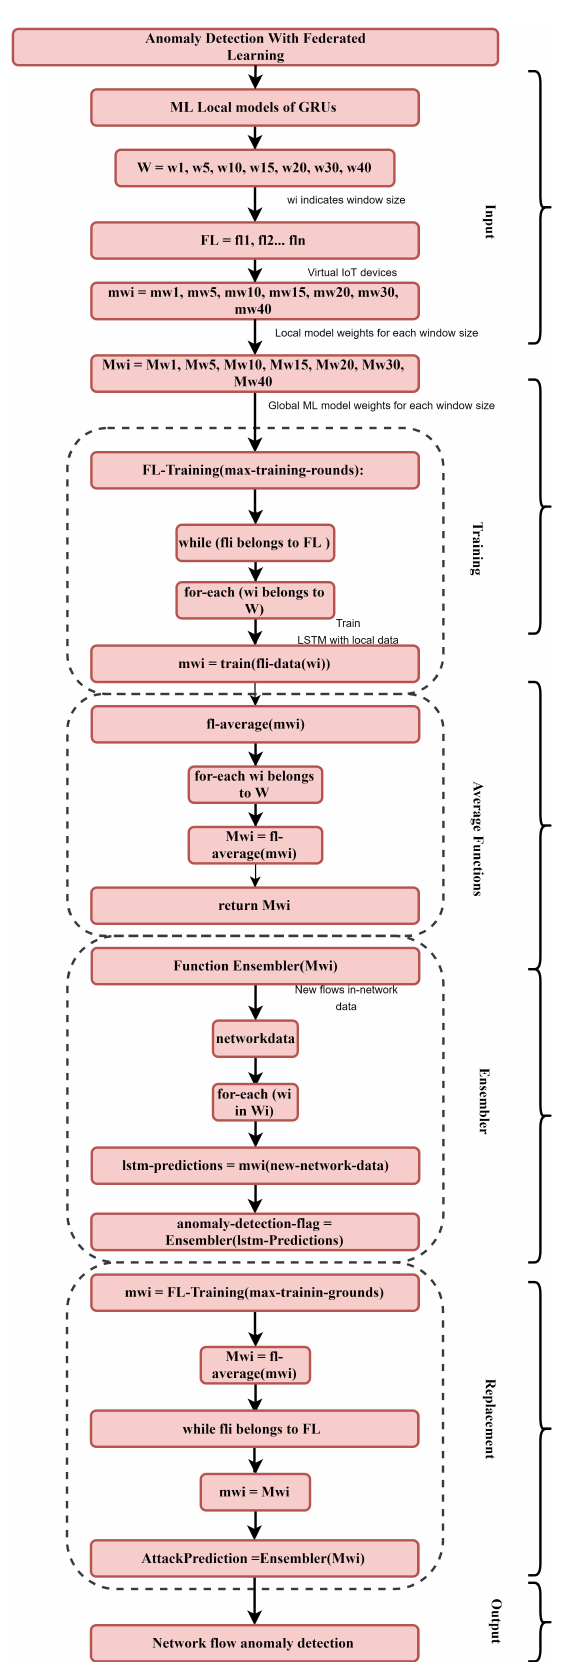
Figure 4. Algorithm 1: Proposed Technique of Attack